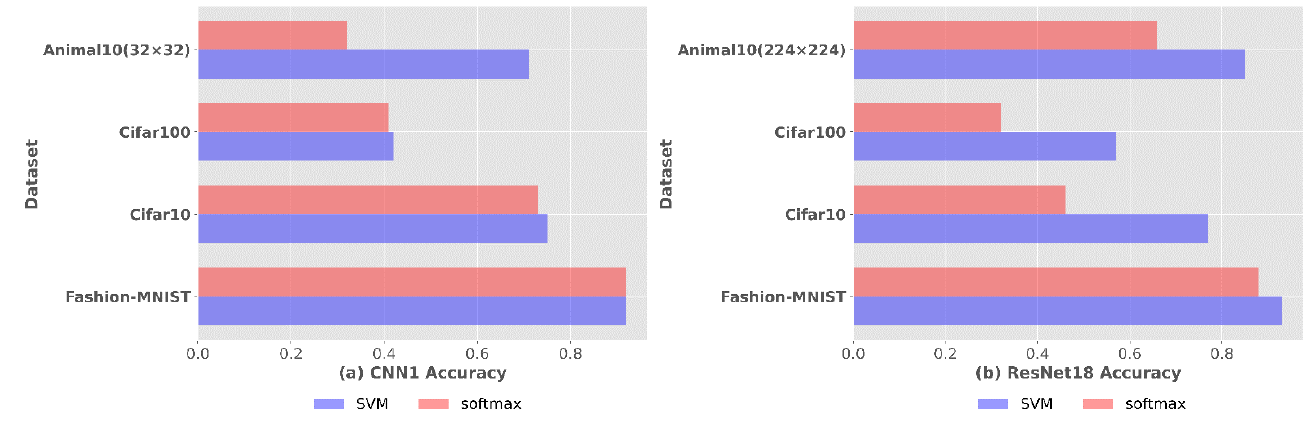
Figure 5. Classification accuracy of test set with training set learning rates of 0.01, 0.001, and 0.0001. The network model in Figure 5 is based on the CNN1 structure under the CASVM (squared hinge) framework, using Fashion-MNIST for training and testing, to derive the impact on network training at learning rates of 0.01, 0.001, and 0.0001. It is known through the experiment that the test set accuracy is unstable when the learning rate is 0.01, which eventually leads to a significant error. Therefore, we used learning rates of 0.001, 0.0001, and 0.00001 as model comparison parameters. 4.1.4. Optimizer Impact and Selection The optimizer updates and computes network parameters for model training and output. Commonly used optimizers are Adam, SGD, and RMSProp. Adam combines the advantages of Momentum and RMSProp by dynamically adjusting the learning rate of each parameter using first- and second-order moment estimation of the gradient.